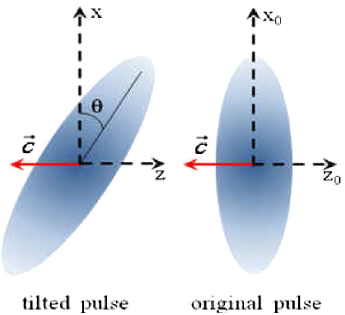
FIG. 4. The correspondence of the photon positions between the normal and tilted incident laser